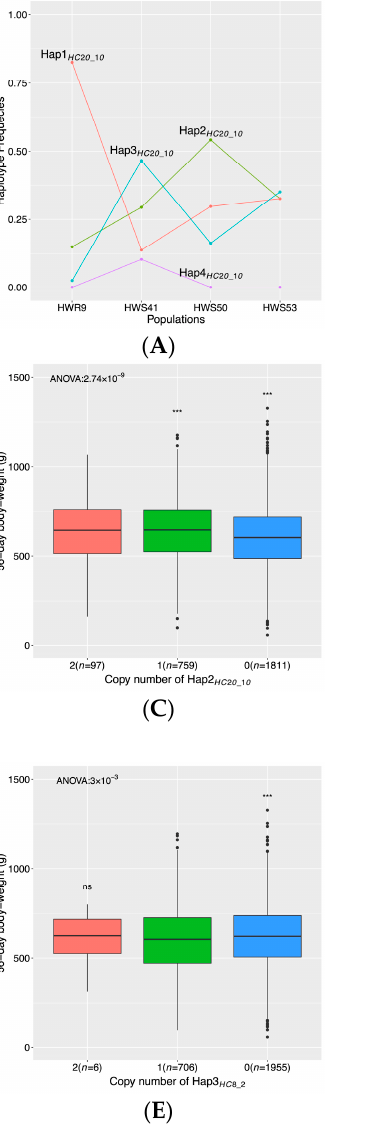
Figure 4. Purging regions in the HW lineage with associations to 56-day body weight. The top panel presents results for the purging region on chromosome 20 (10.7–10.8 Mb). In ( A ), the large changes in haplotype frequencies for Hap1 HC20_10 and Hap2 HC20_10 across the four HW populations are consistent with purging. In ( B ) and ( C ), box plots of 56-day body weights are shown for chickens with no, one, and two copies of these haplotypes ( Hap1 HC20_10 in ( B ); Hap2 HC20_10 in ( C )). In bottom panel, ( D ) haplotype frequency changes consistent with purging are shown in the purging region on chromosome 8 (2.4–2.7 Mb). In ( E ) and ( F ), box plots illustrate 56-day body weight distributions for AIL individuals with no, one, and two copies of these haplotypes ( Hap3 HC8_2 in ( B ); Hap1 HC8_2 in ( C )). Overall p -values in B/C/E/F were from the one-way ANOVA analysis. Stars denote the significance of pair-wise tests between genotypes calculated by a t -test (*/**/ns represent p < 0.05/0.01/non- significant).